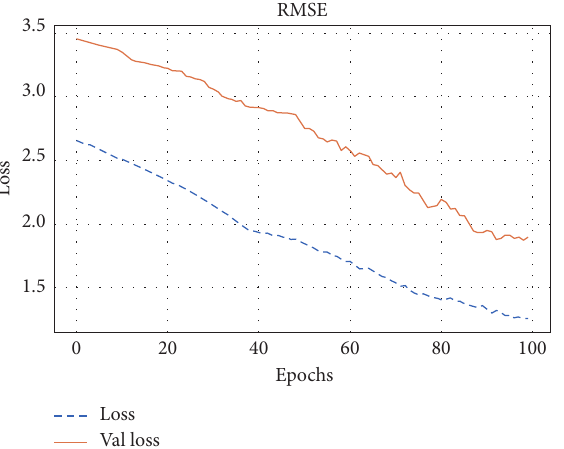
Figure 12: Validation of the model in terms of RMSE.